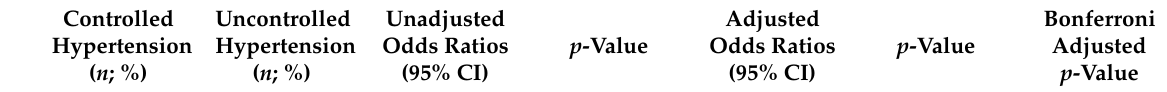
Table 5. Adjusted and unadjusted logistic regression models showing genotypes and alleles associ- ated with blood pressure